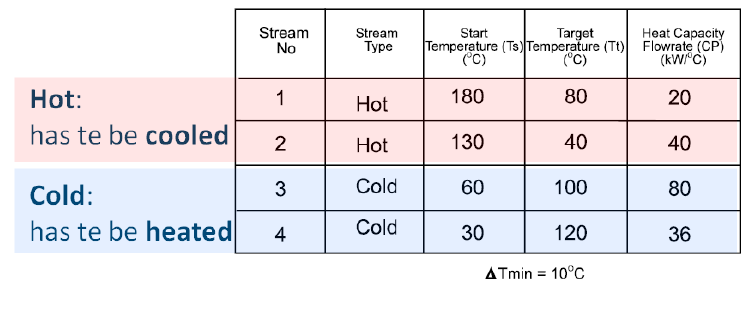
Fig. 27. – Translation form the Process Flow-sheet (left) into the Data Extraction Flow-sheet (right) [10].